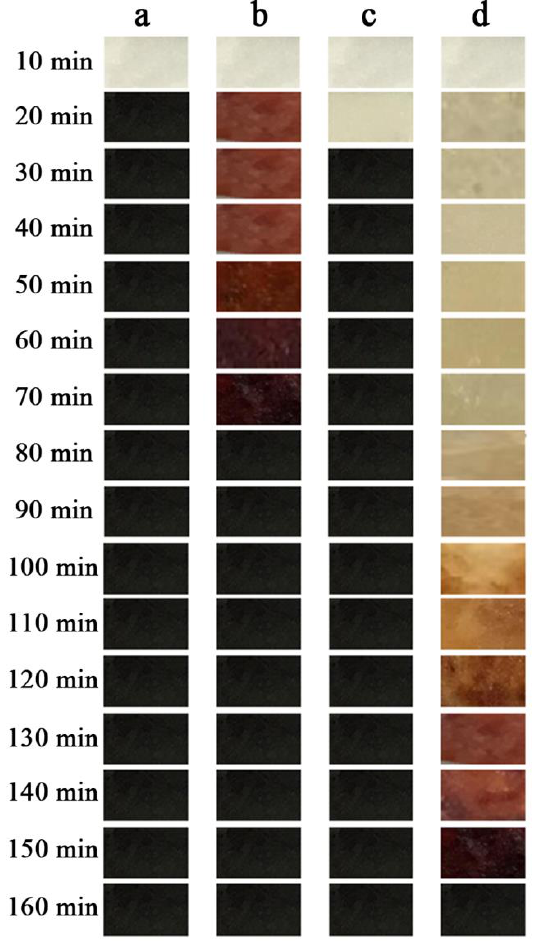
Figure 7. Thermal stability of ( a ) pure PVC and composites of ( b ) PVC + LDHs, ( c ) PVC + ZnSt 2 and ( d ) PVC + LDHs + ZnSt 2 .